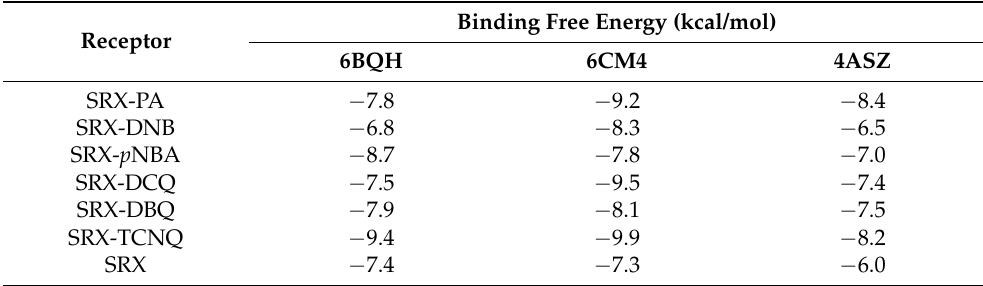
Table 2. The docking score of six synthesized CT complexes docked with three receptors [serotonin (PDB ID: 6BQH), dopamine (PDB ID: 6CM4), and TrkB kinase (PDB ID: 4ASZ)].